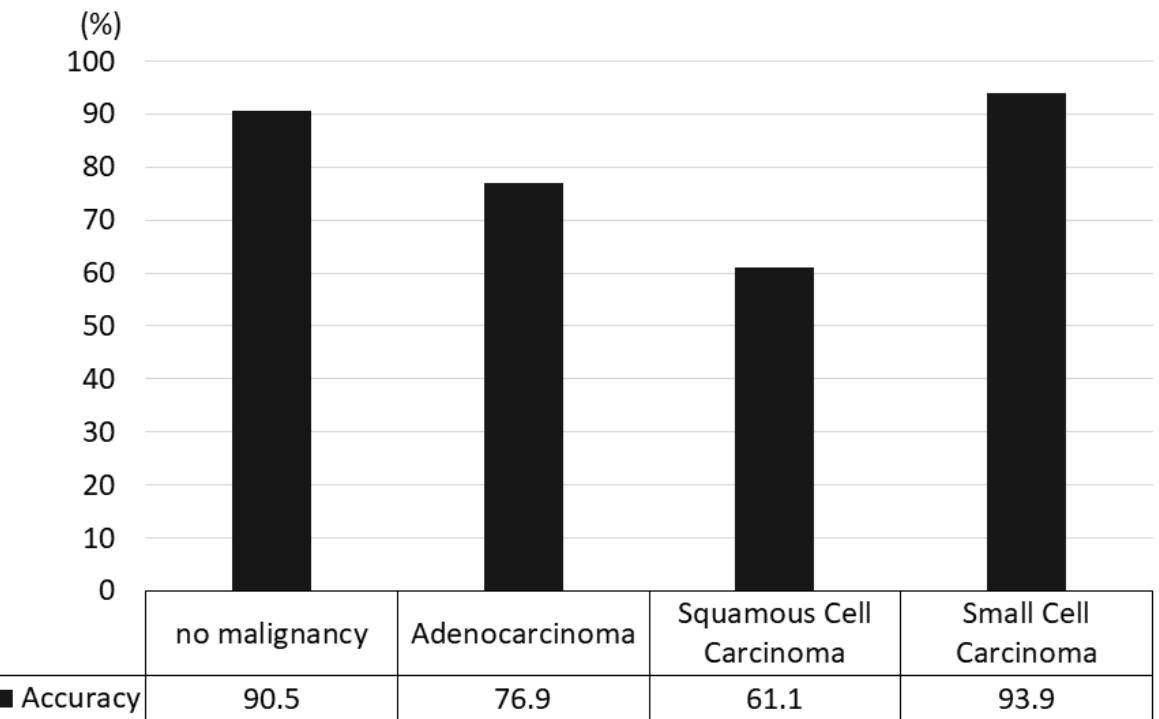
Figure 5. The accuracy rates of the hold-out method by lung cancer subtype.